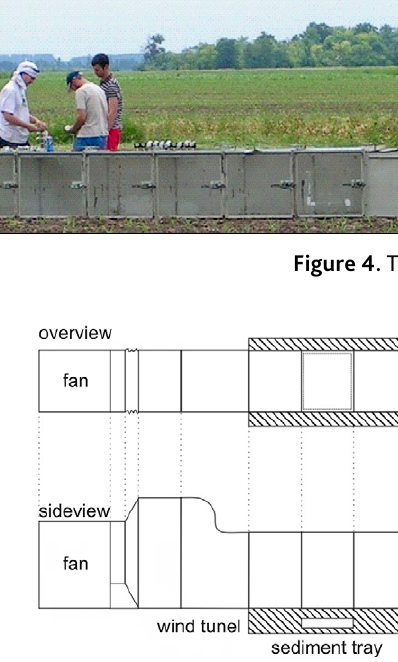
Figure 5. The location of the soil sample points, the WAST traps and the sediment traps at the end of the tunnel (Farsang et al. 2022)